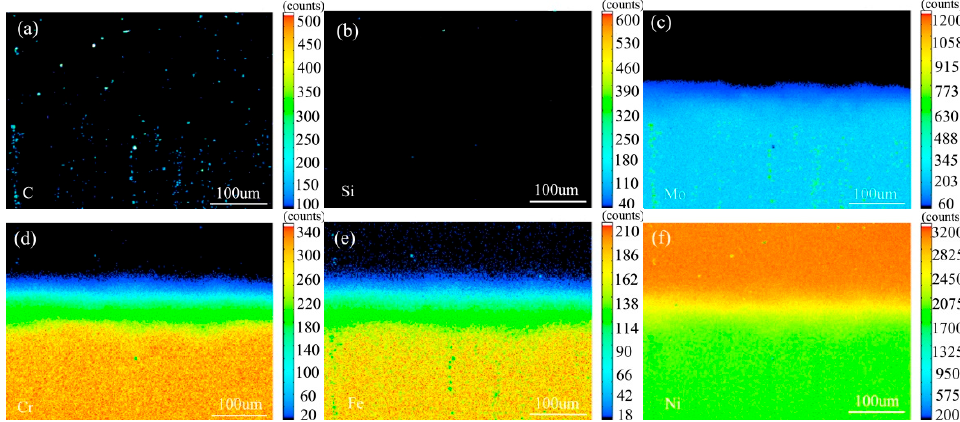
Figure 13. Composition distribution map of the diffusion couple sample of 0Si alloy and pure nickel after 1000 °C/200 h heat treatment: ( a ) C, ( b ) Si, ( c ) Mo, ( d ) Cr, ( e ) Fe, and ( f ) Ni.